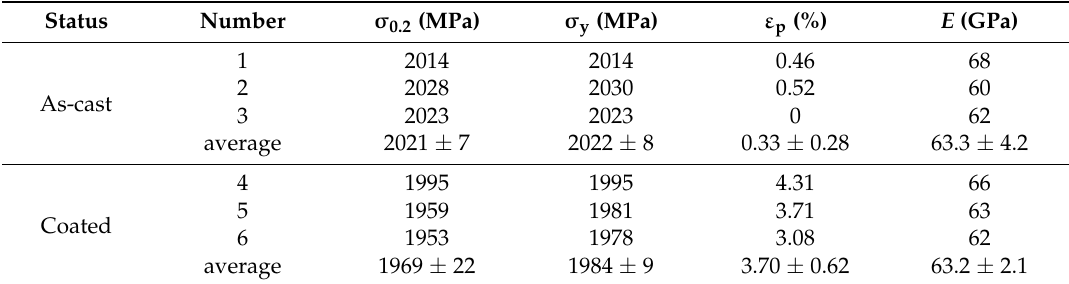
Figure 5. The compression engineering stress-strain curves of the Ni-coated BMG samples together with the as-cast Ti-based bulk metallic glasses (BMG) samples. Table 1. The mechanical properties of the as-cast bulk metallic glasses (BMG) samples and the coated BMG samples measured from the stress-strain